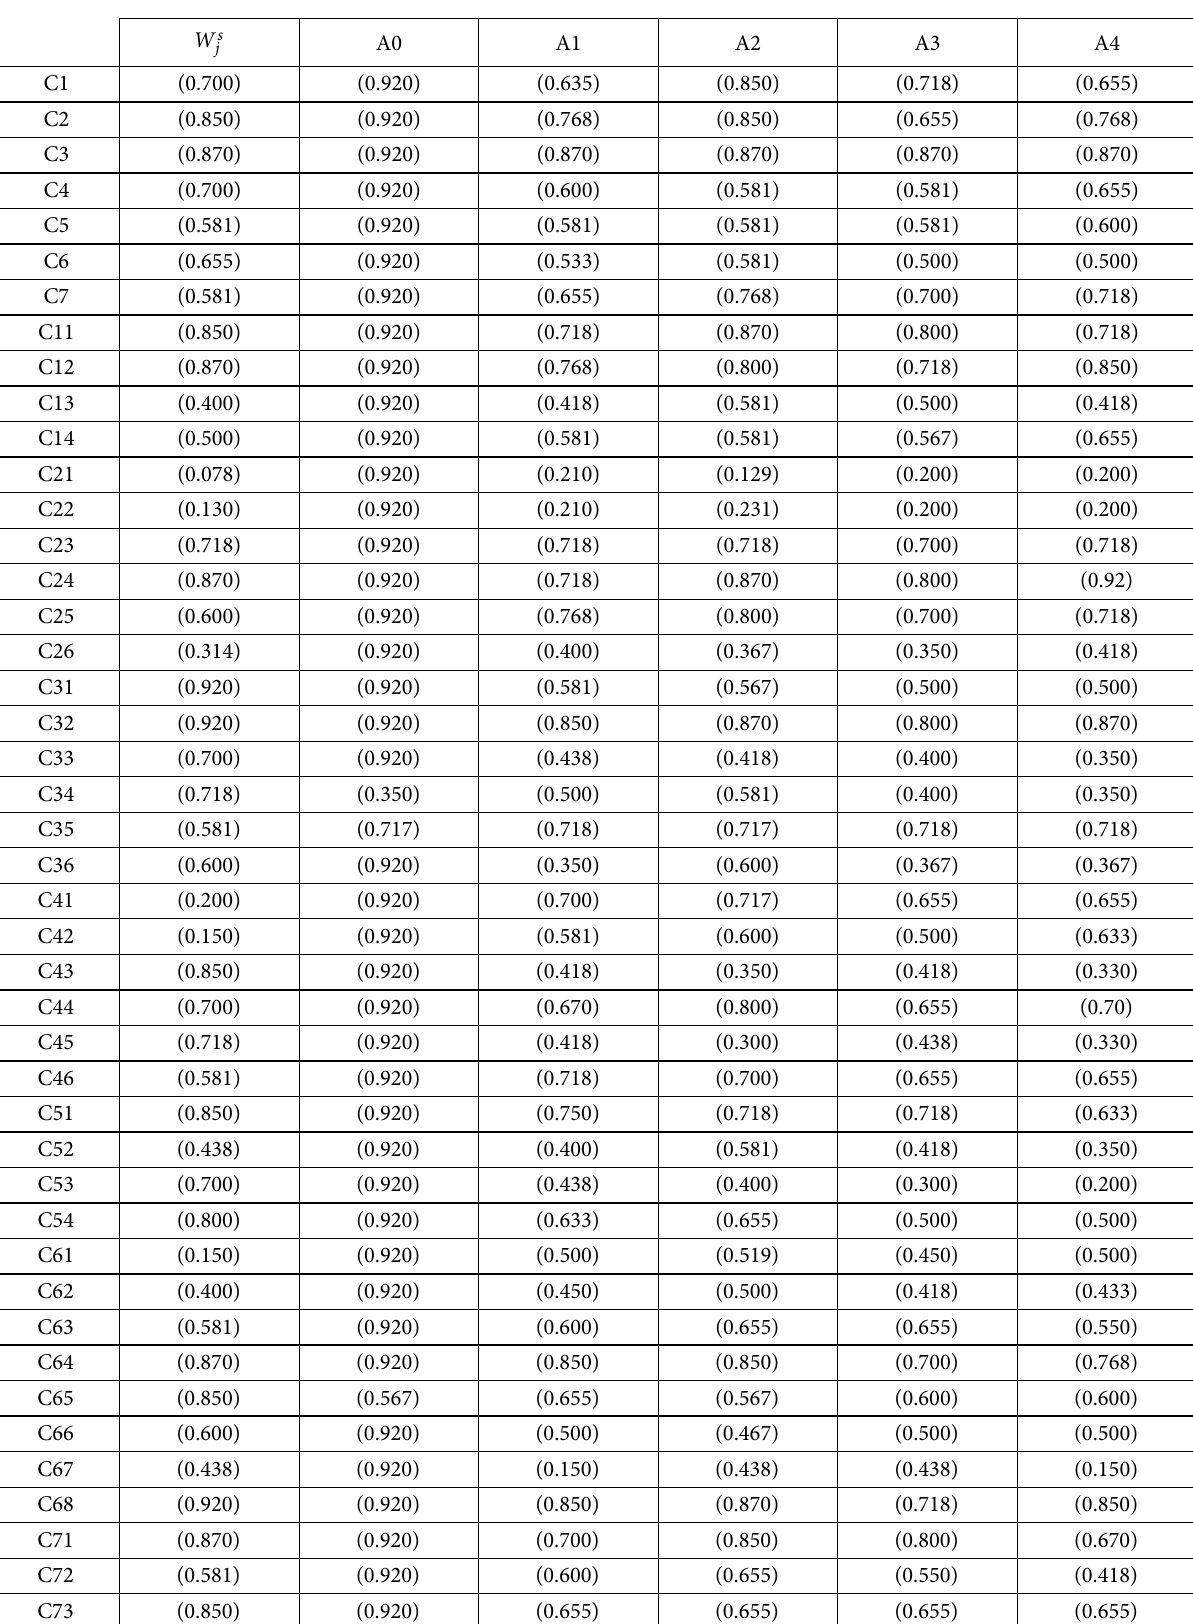
Table 8. Defuzzified aggregated fuzzy values of firms’